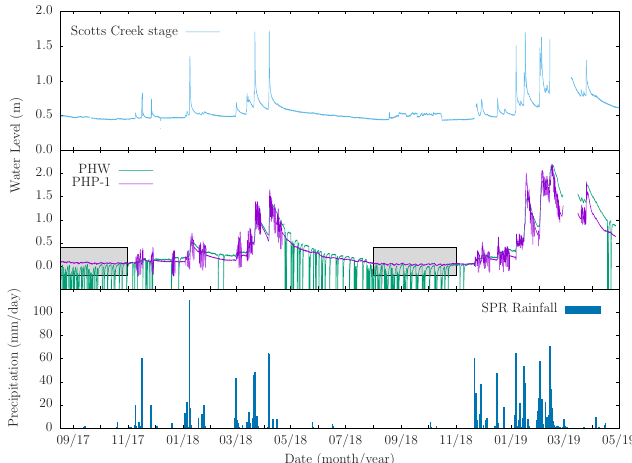
Figure 11. Groundwater fluctuations observed in piezometer PHP-1 and the Pump House irrigation well from 18 August 2017 through 26 April 2019. Daily precipitation of Swanton Pacific Ranch and stage of Scotts Creek are shown over the same period. The gray boxes represent the two zoomed-in time periods shown in Figure